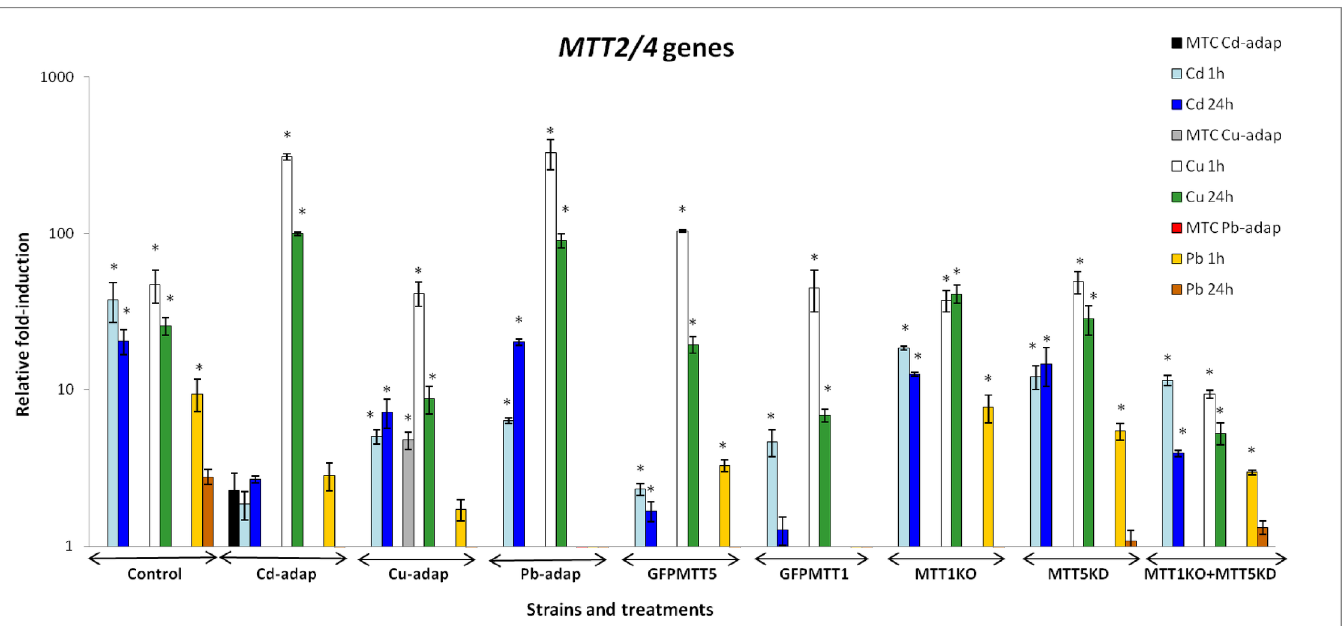
Fig 5. Comparison of relative fold-induction of MTT2/4 in different T . thermophila strains. MTC: maximum tolerated concentration (115 μ M Cd 2+ , 4 mM Cu 2+ or 5.5 mM Pb 2+ ). β -actinwas used as the normalizergene. Each histogrambar represents an averagevalue ± standarddeviation(see S3 Table) from two or three independentexperiments. Relativeinductionvalues are representedin a logarithmic scale. Asterisks indicatesignificantdifferencesfrom the control with p (cid:20)